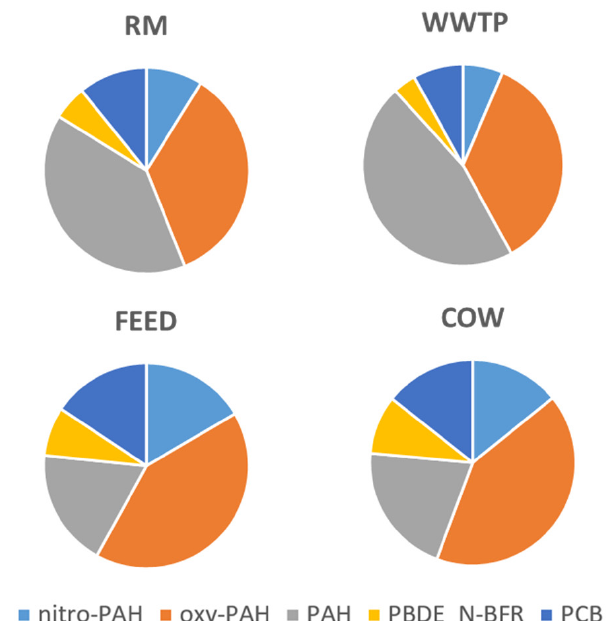
Figure 3. Pie chart reporting organic contaminant group concentrations in ng per mg of PM10, in the four sampling sites.